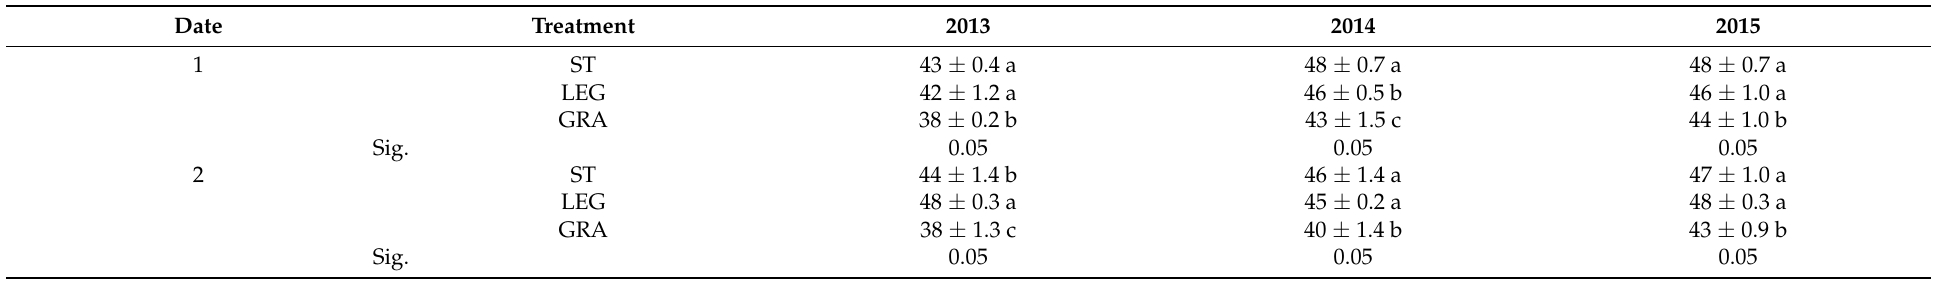
Table A2. SPAD average values ± standard error in the main leaves, collected close to dates 1 and 3 of downy and powdery mildew observation in shoots, different letters indicate significant differences among treatments at p <